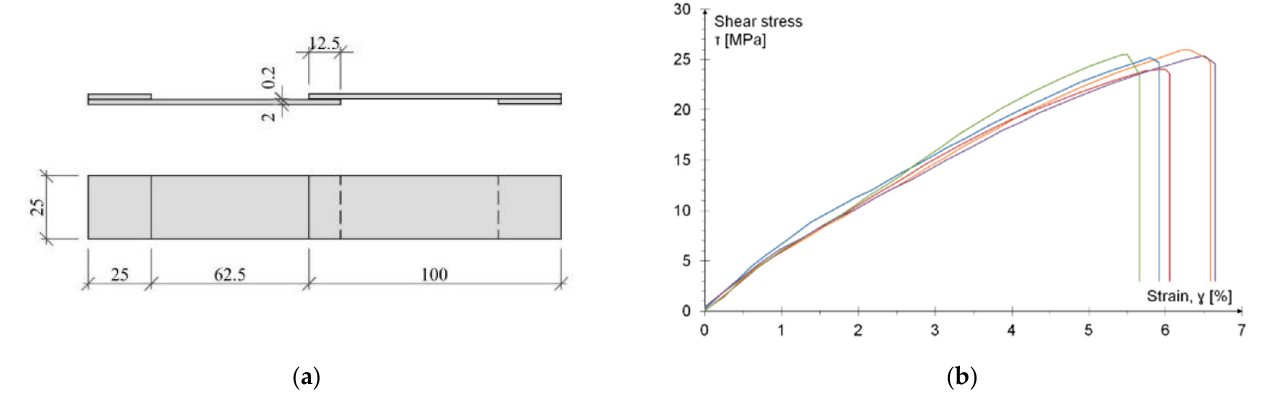
Figure 3. Single-lap joint test: ( a ) geometry of the tested specimen; ( b ) stress-strain relationship (indirectly determined). The line colors were assigned to the next five identical samples.